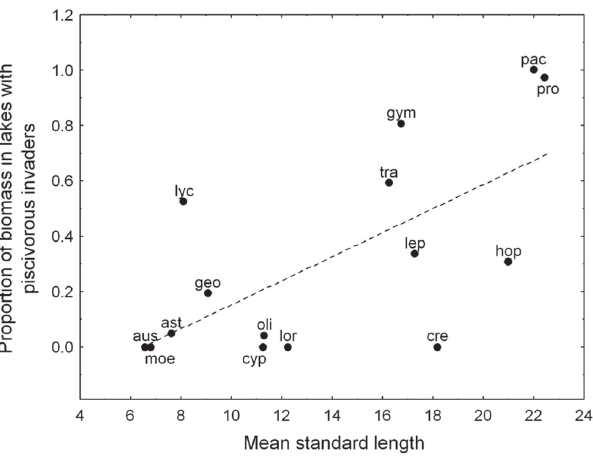
Fig. 3. Relative biomass of native species along a gradient of relative biomass of non-native species. From left to right, there is an increase in the relative biomass of non-native species (except for the first three which contains only native species and were ordered arbitrarily). Lake codes: No = Nova; Ca = Capim; Fe = Ferrugem; Cr = Crentes; Po = Poço Redondo; Ro = Romoalda; Ti = Timburé; Ag = Águas Claras; Pa = Palmeirinha; Ar = Ariranha. “Natives” represents lakes without non-native species; “Non-piscivores” represents lakes with non- piscivores non-native species; “Piscivores” represents lakes with non-native piscivorous species.The species were ordered arbitrarily, in such a way to make a gradient more visible. The relative biomass sum to 100% along each horizontal line that represents a species (the scale is not the same for every